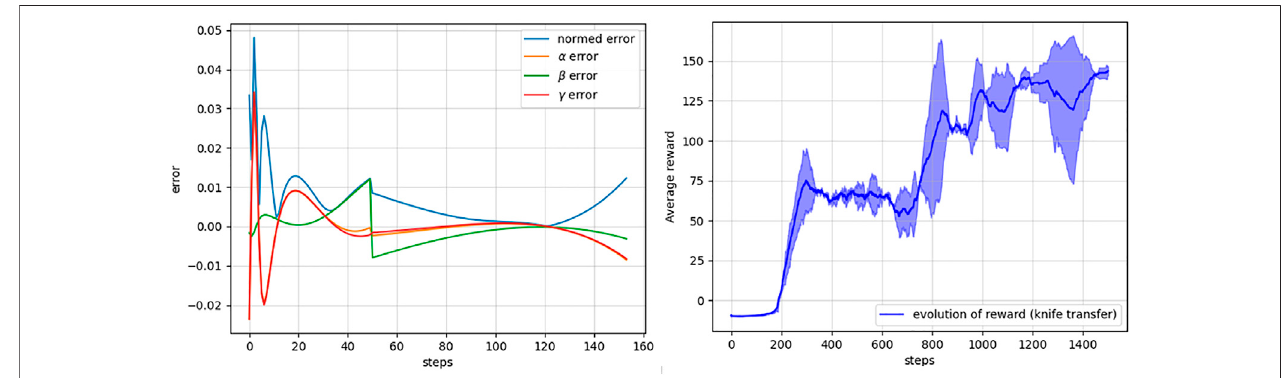
FIGURE9| Left:prediction errorsofthe learned Koopmanoperator forthe orientation elements, α , β , γ ,or roll, pitch, and yaw elements with respectto theground truth over different steps. Right: mean and standard deviation ofthe cumulative rewards over the episodes during the training ofthe DRL agent for the knife transfer task obtained with multiple trial runs of the learning